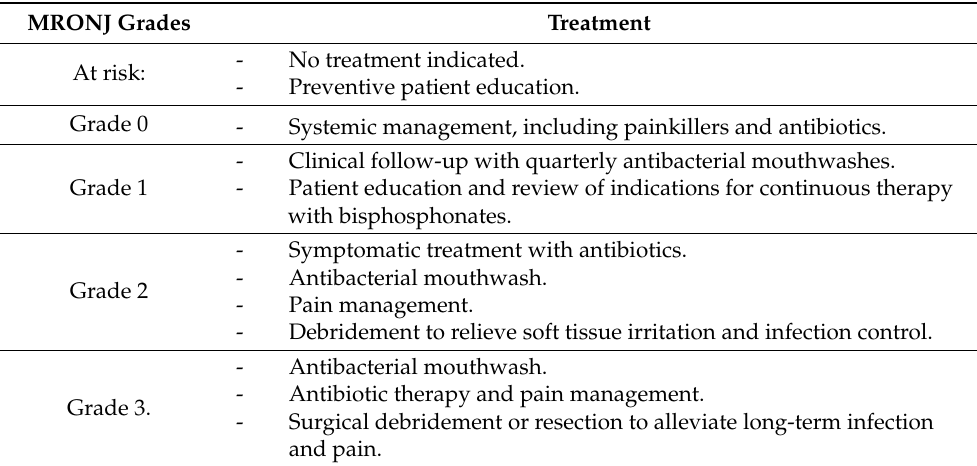
Table 2. Recommended treatments according to the grade or stage of